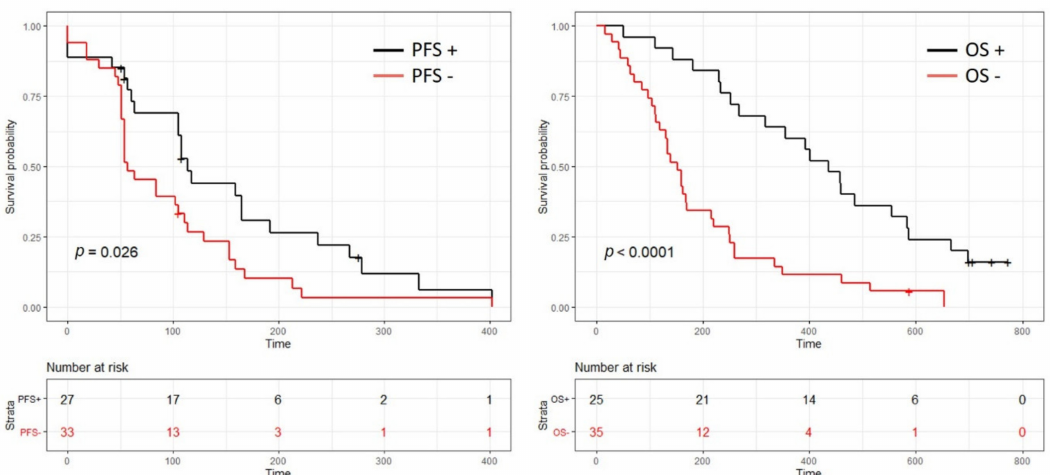
Figure 1. Kaplan–Meier plots for both progression free survival (PFS) (left side) and overall survival (OS) (right side). The black curve identifies the patient whose blood-based transcriptomic profile is favorable to gemcitabine treatment as a 1st line therapy. The red curve identifies the patient whose blood-based transcriptomic profile is unfavorable (a low response and risk of potential toxicities) to gemcitabine treatment as a 1st line